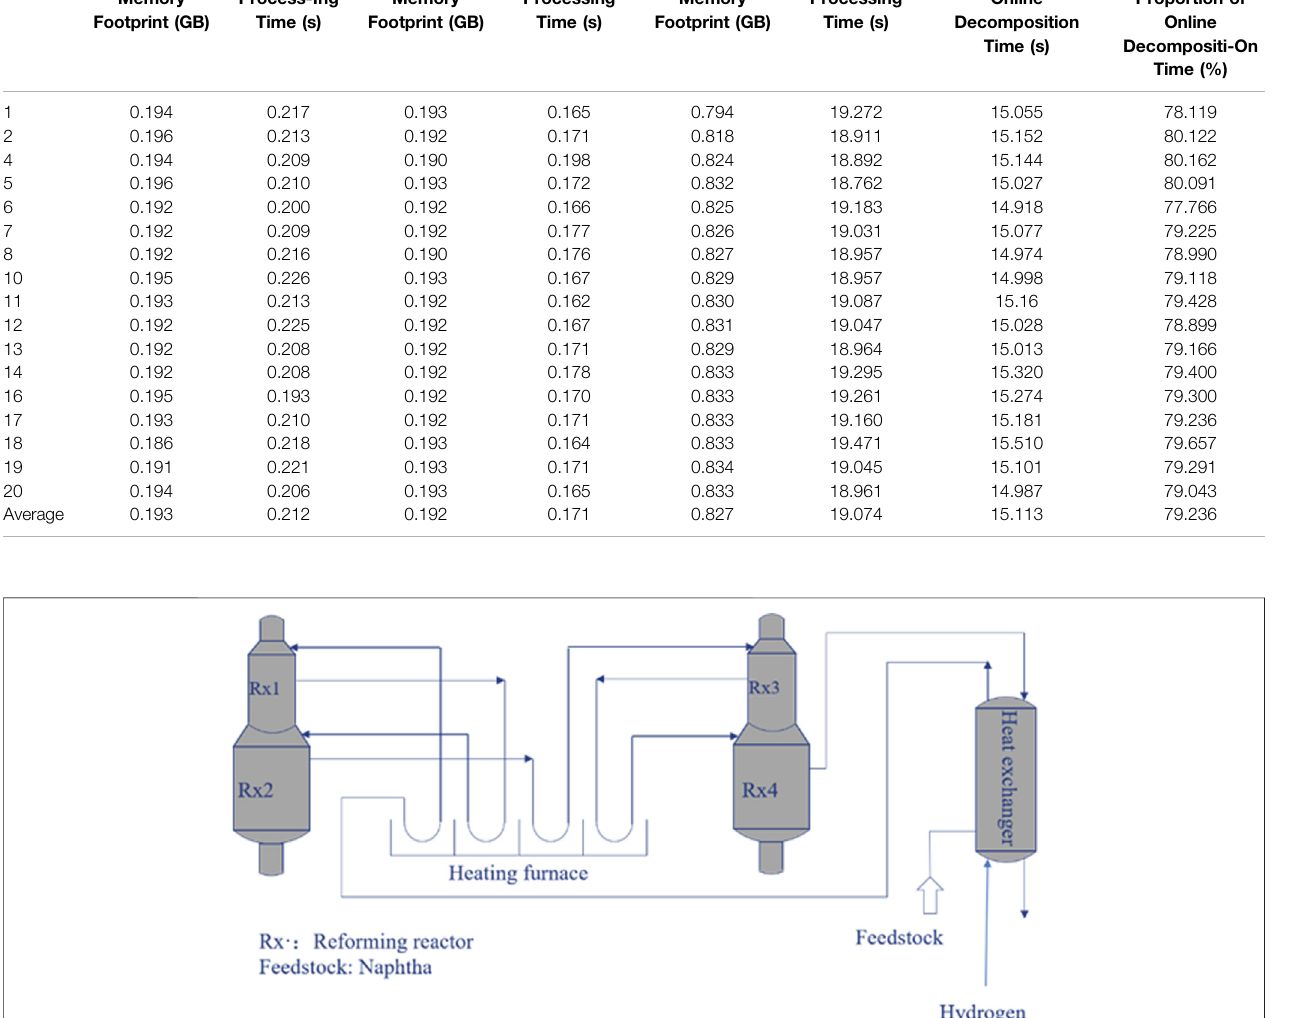
TABLE 4 | The computational load of PCA, SFA and the proposed method in the TEP dataset. Fault No.